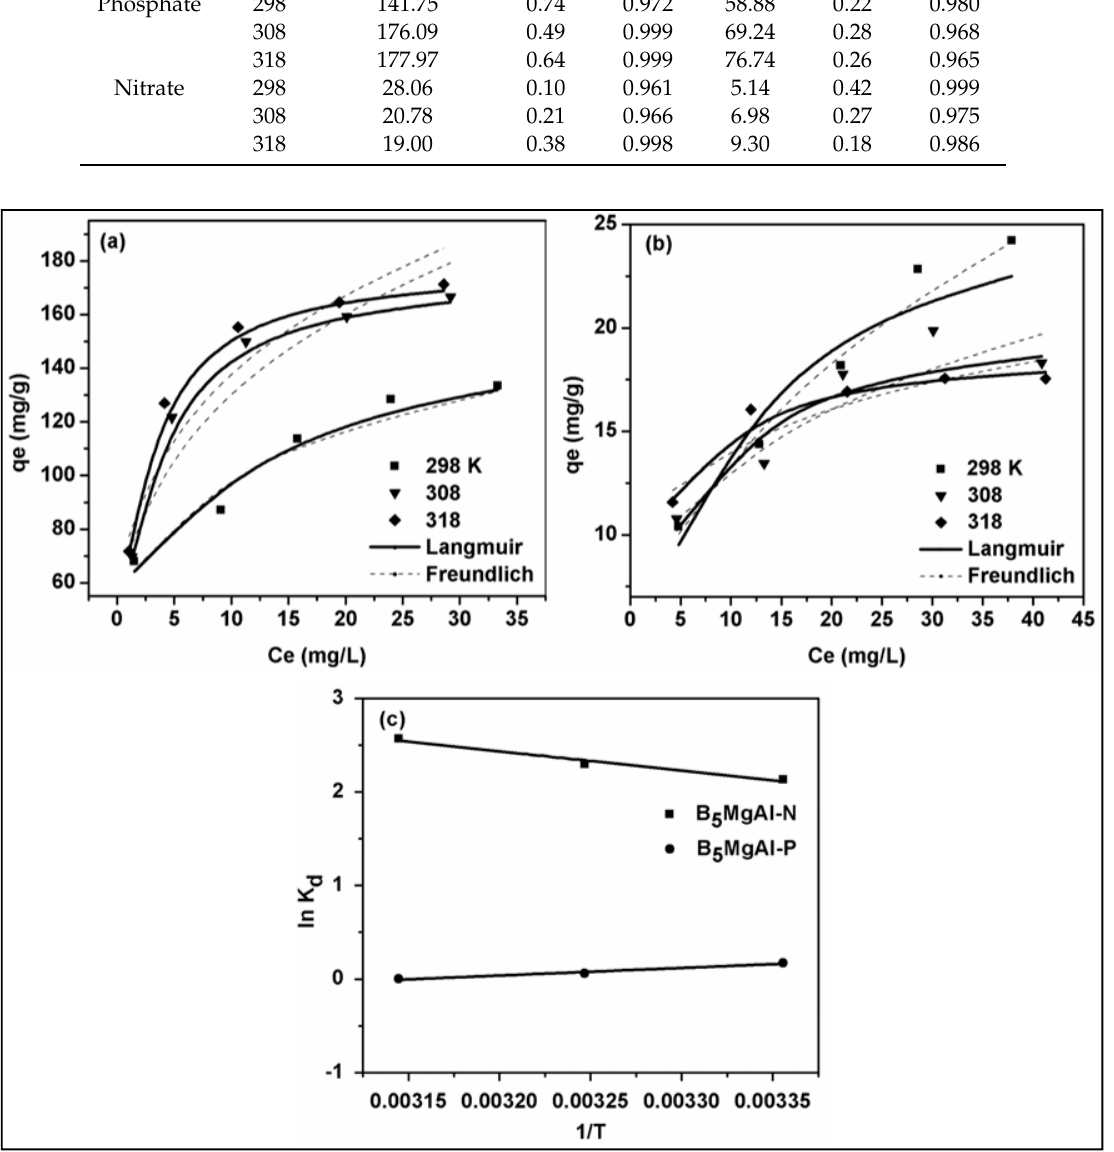
Figure 6. Non-linear isotherm models of phosphate ( a ) and nitrate ( b ) removal onto biochar / MgAl composites, plot of ln K d against 1 / T for the estimate of thermodynamic parameters ( c ).